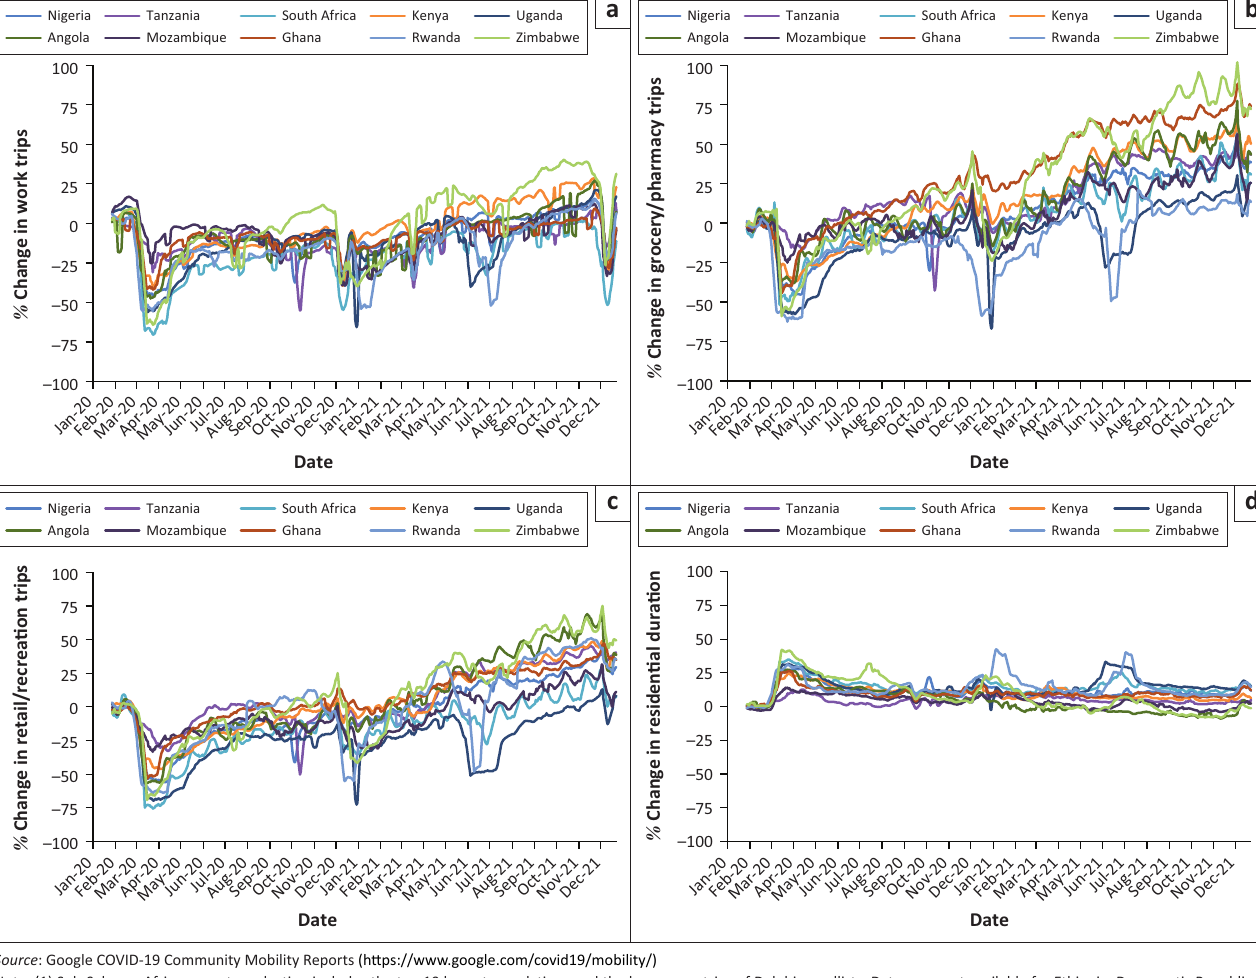
FIGURE 2: Change in trips to workplaces and shopping activities and residential duration in selected sub-Saharan African countries ( n =